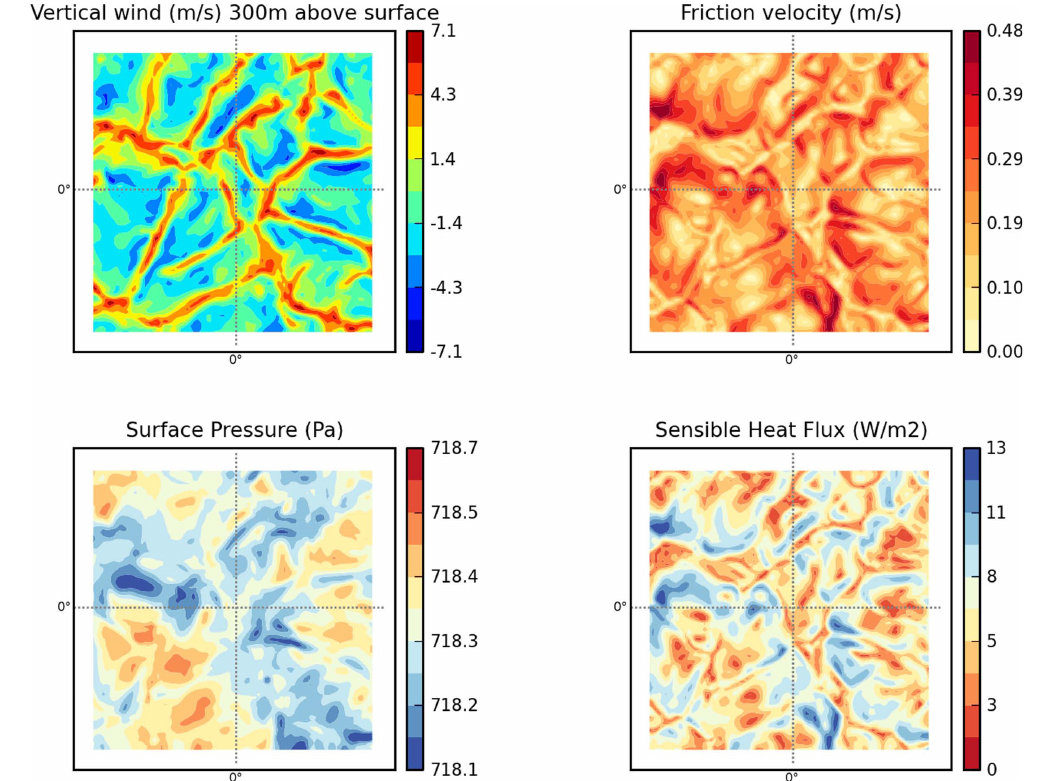
Fig. 1. Convective cells in daytime convective PBL. Results are obtained through large-eddy simulations in the Martian environment. Similar organization is observed for the daytime convective boundary layer in terrestrial arid regions. The dimension of the simulation domain is ∼ 10km. Results are shown at